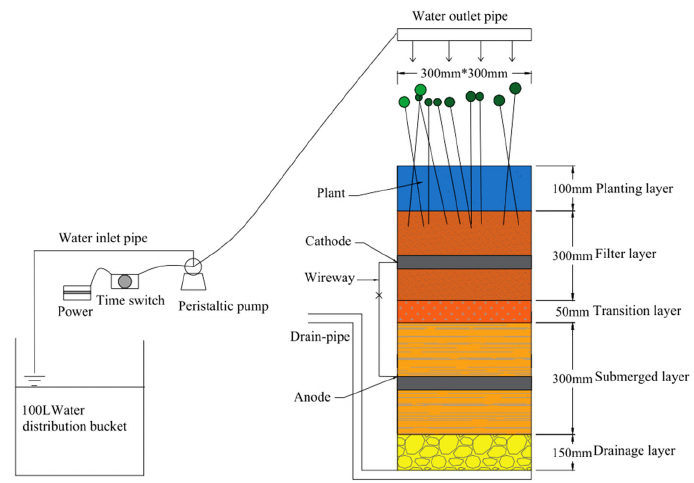
Figure 1. Bioretention cell–microbial fuel cell (BRC ‐ MFC) device diagram.